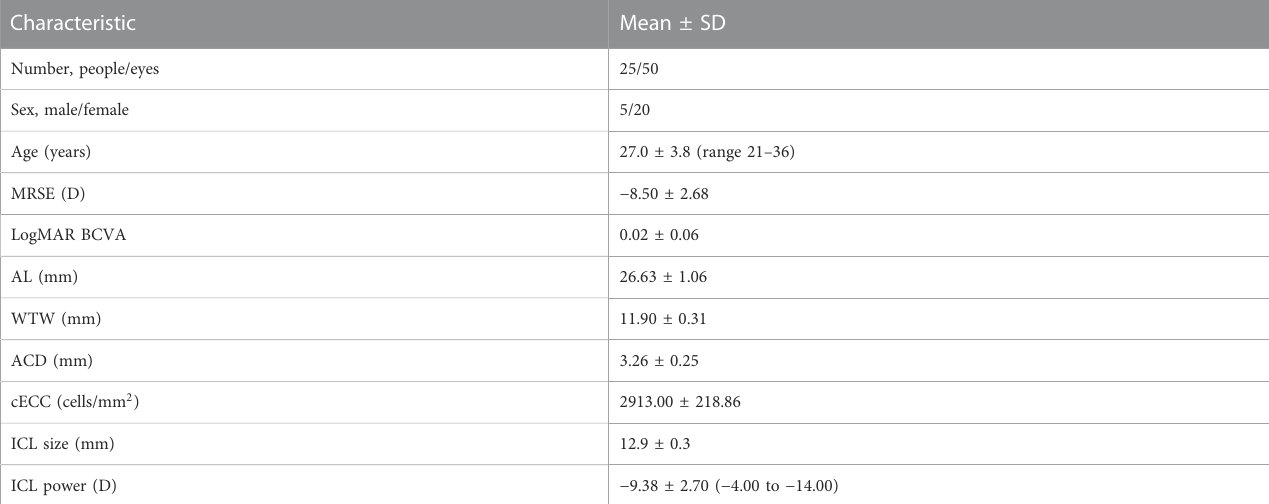
TABLE 1 Preoperative demographics of the myopia patients underwent implantable collamer lens implantation in this study. Characteristic